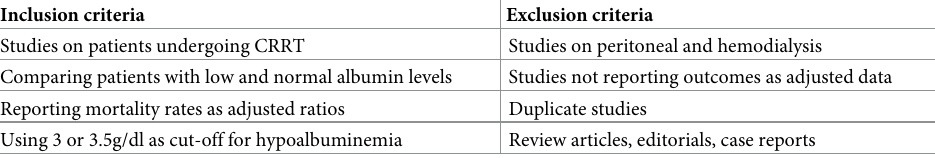
Table 1. Inclusion and exclusion